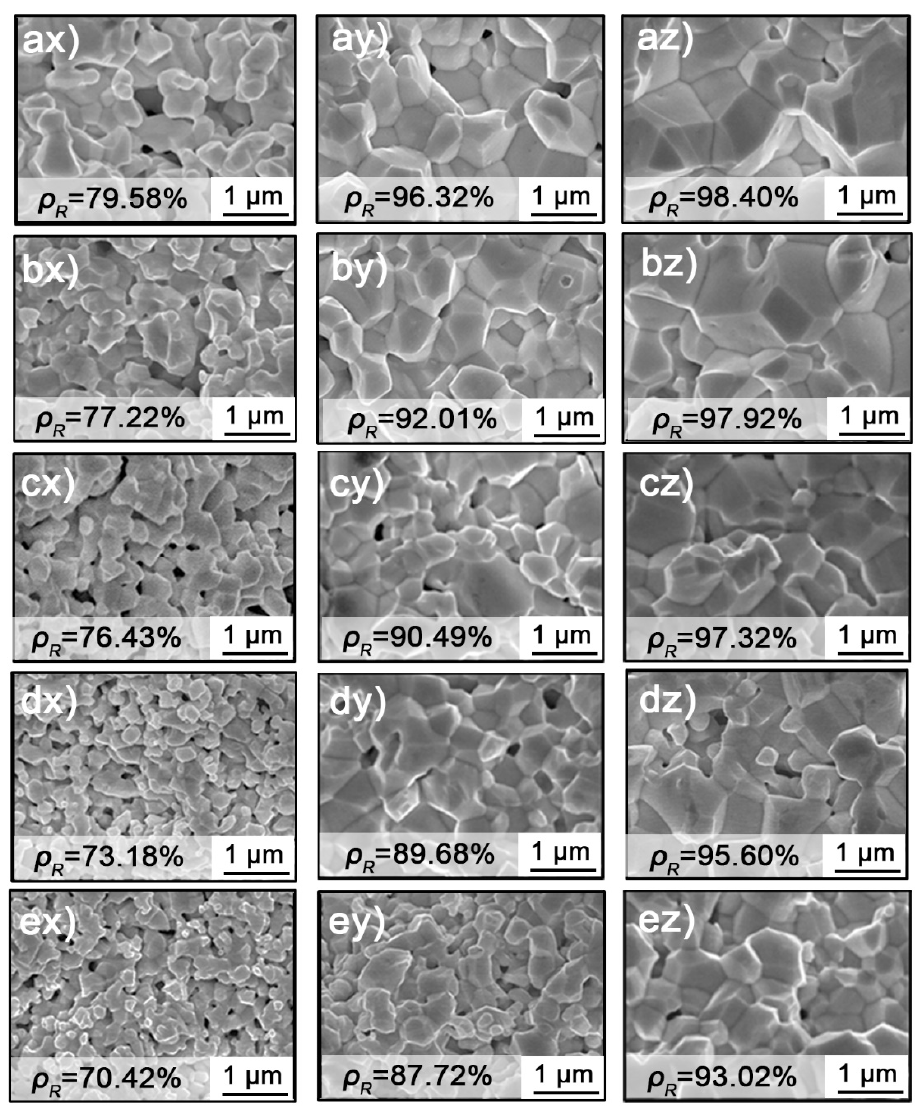
Figure 1. Samples sintered at different temperatures ( x – z ) 1300, 1500, 1700 °C (hold for 10 min) and multiple heating rate ( a – e ) 1, 5, 10, 20, 40 °C/min with different relative density.